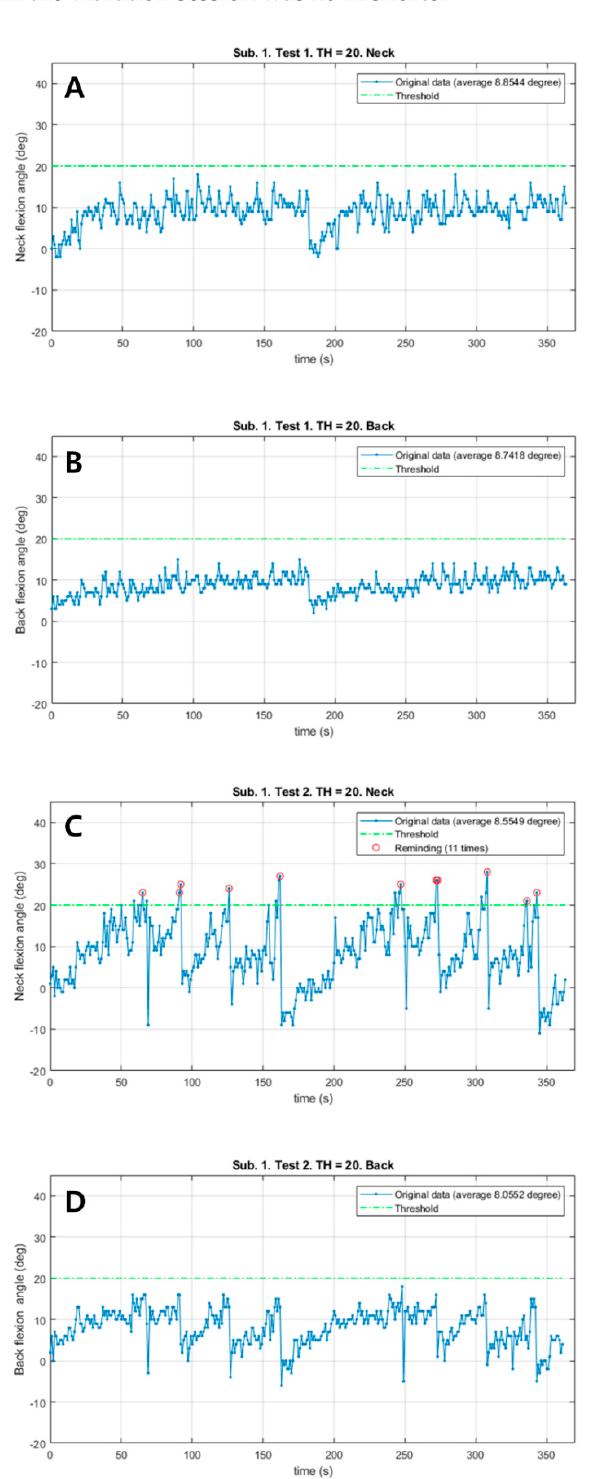
Figure 2. The changes of neck and back flexion angles continuously measured during 6 min walk test in patient #1. ( A ) The changes of neck flexion angles in the control session. ( B ) The changes of back flexion angles in the control session. ( C ) The changes of neck flexion angles in the vibration session. ( D ) The changes of back flexion angles in the vibration session. Red circles: Reminding the patient by vibration